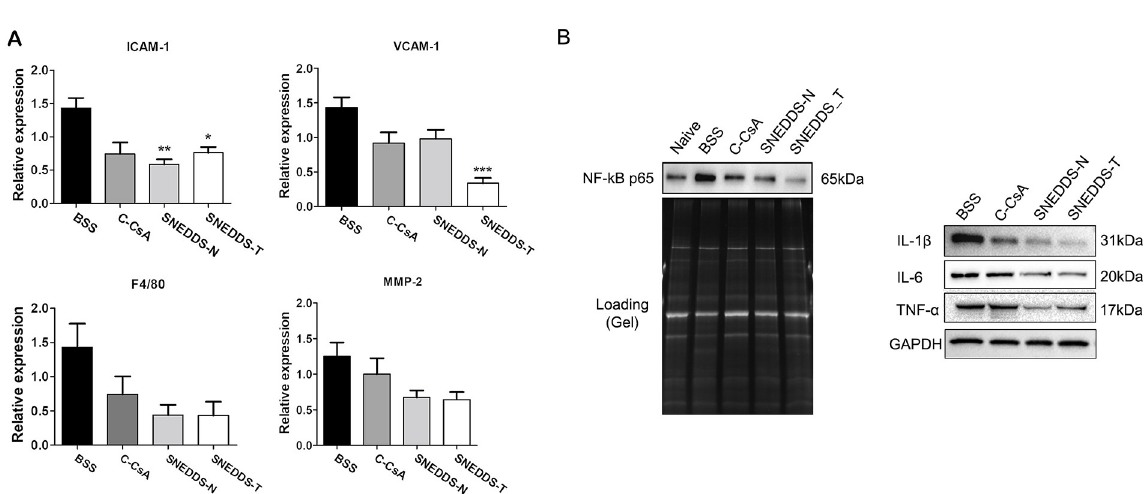
Fig 8. (A) Real-time PCR was used to quantify corneal mRNA expression of Icam-1 , Vcam-1 , F4/80 and Mmp-2 in each subgroup (n = 5). (B) Corneal NF- κ B activation and IL-1 β , IL-6 and TNF- α expression were assessed by western blot analysis (n = 5). Data are expressed as mean ± SD. � P < 0.05, �� P < 0.01, ��� P < 0.001 by independent